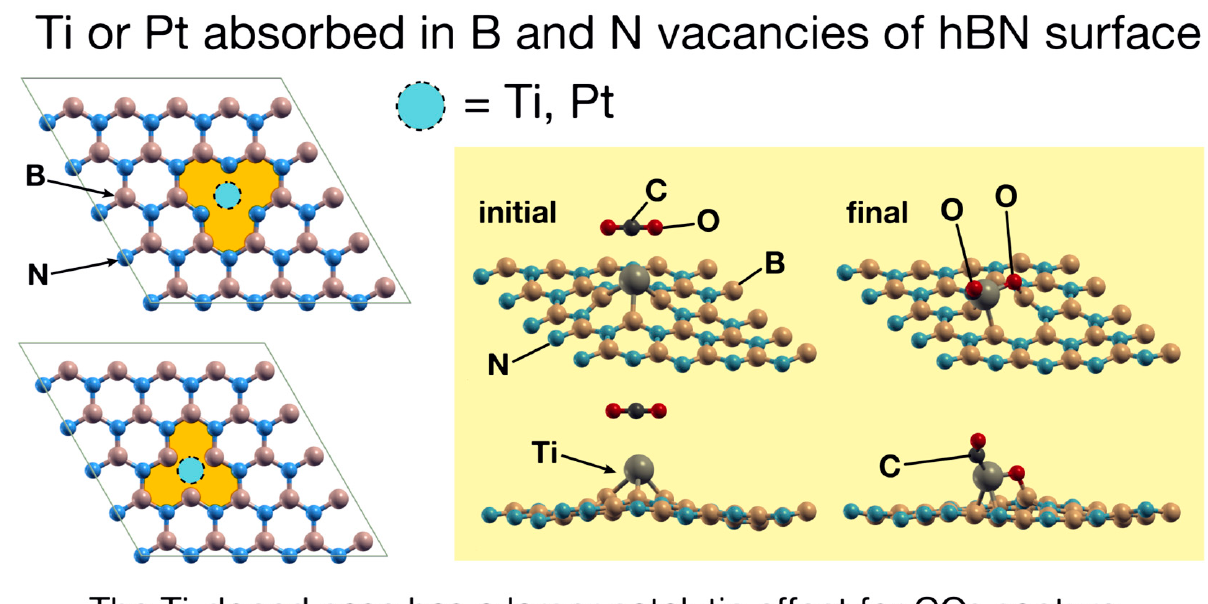
Figure 2. The main results presented on the previous work [17] from which this work builds. Ti– doped hBN showed a larger ability to capture CO 2 , compared to Pt doping.